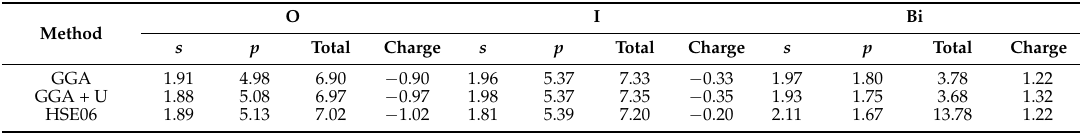
Table 2. Atomic Mulliken populations of BiOI obtained by the different DFT (density functional theory) methods (the unit is elementary charge (symbol: